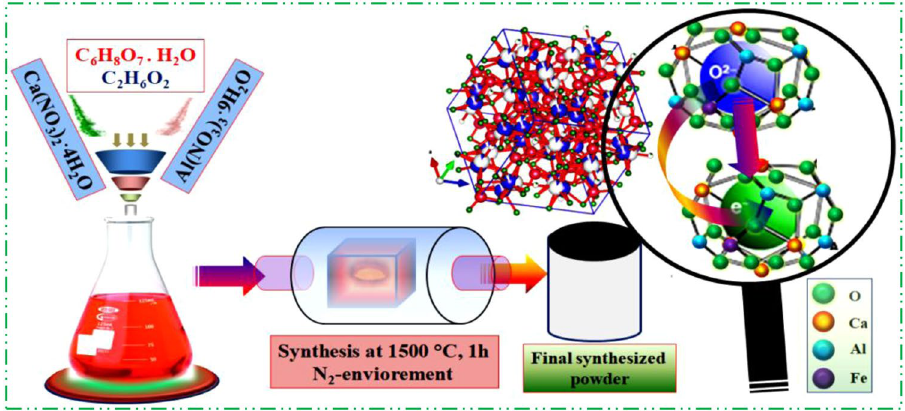
Figure 1. Synthesis scheme of Fe-doped C12A7:e −